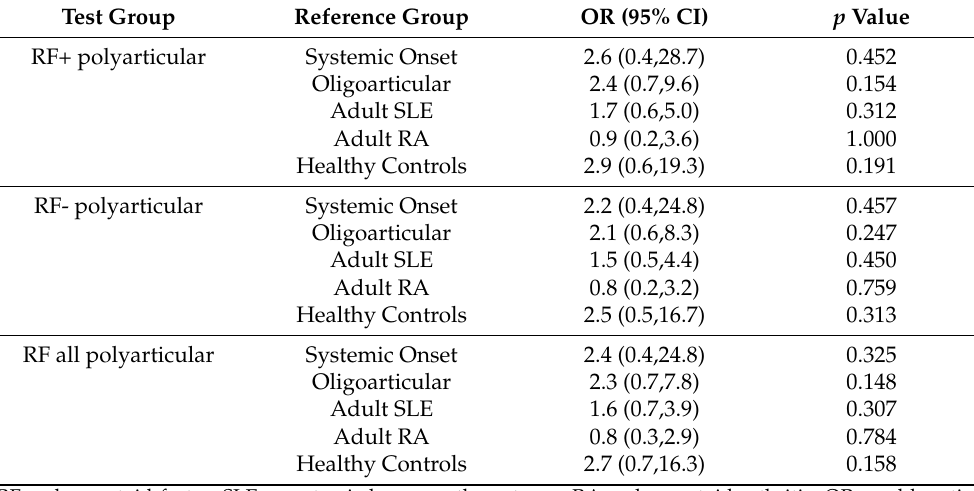
Table 3. Two-Group comparisons of 14-3-3 η test results using the 0.2 ng/mL cutoff.